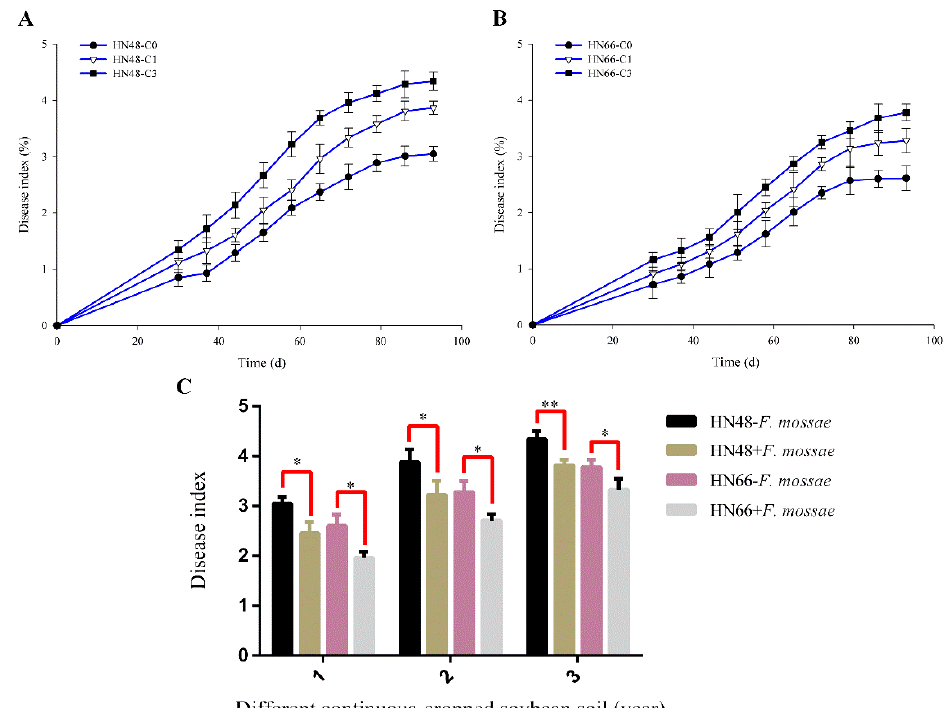
Figure 1. The root rot disease index under different continuous-cropped year soil in potted-experiments of soybean: 1 means soybean were planted the normal soil; 2 means soybean were planted in one-year continuous cropping soybean soil; 3 means soybean were planted in three-year continuous cropping soybean soil; C0 means soybean were planted the normal soil without inoculated F. mosseae ; C1 means soybean were planted in one-year continuous cropping soybean soil without inoculated F. mosseae ; and C3 means soybean were planted in three-year continuous cropping soybean soil without inoculated F. mosseae . Note: All experiments were conducted in potted-experiments. ( A , B ) x -axis represents which day detected the root rot disease index of two soybean cultivars; and ( C ) x -axis represents the year of continuous cropping soybean soil. Each value represents the average of six independent experiments and the error bars represent standard deviations. Asterisks indicate the significance of differences between the samples. p values were calculated by Student’s t -test. Single asterisk indicates p < 0.05; double asterisks indicate p < 0.01.